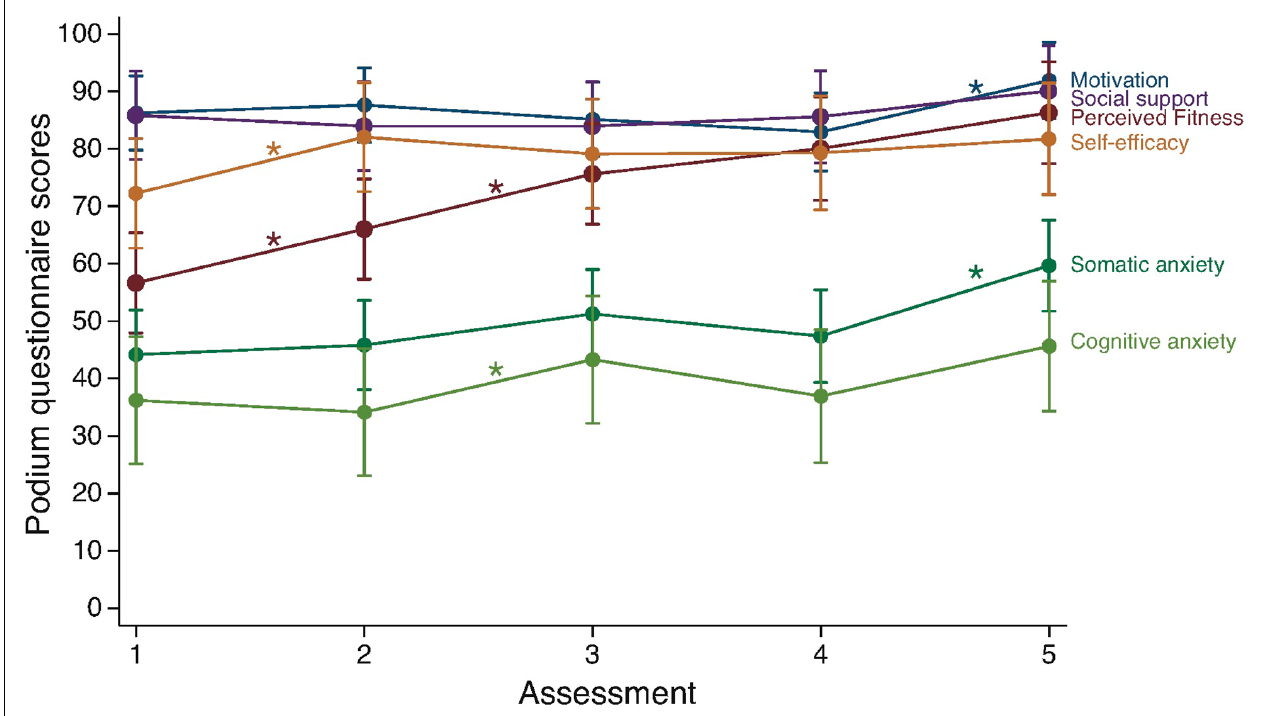
FIGURE 1 | Psychological variables assessed five times over 16 weeks. Assessments were performed at 116, 88, 60, 32, and 11 days prior to competing in the marathon. Data represent mean and 95% confidence intervals adjusted for participant’s random effects. Asterisks represent statistically significant changes ( p <